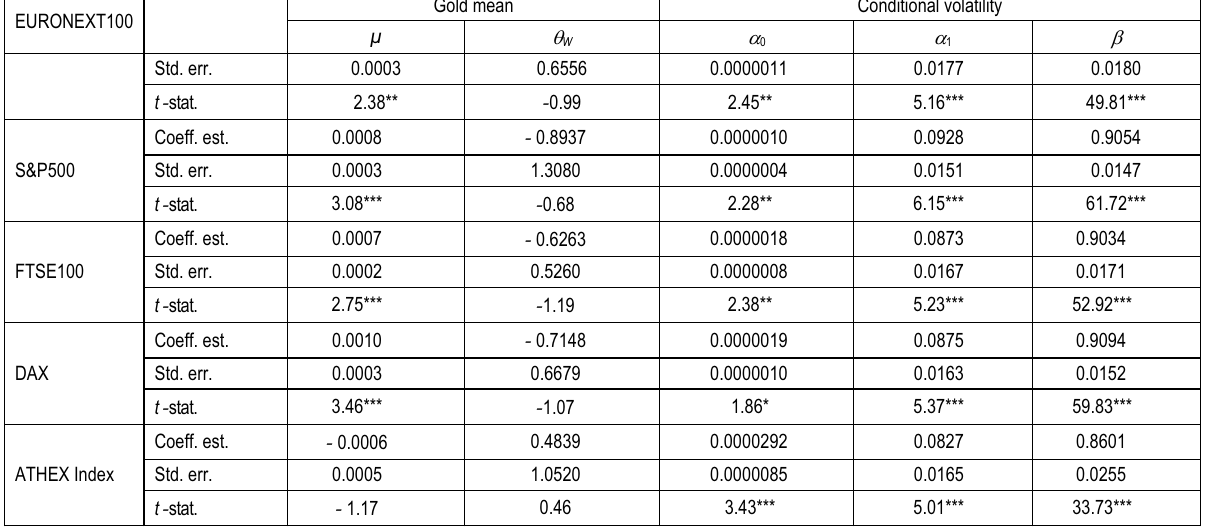
Table 4 (cont.). Estimation results for stock market indices – reverse causality test